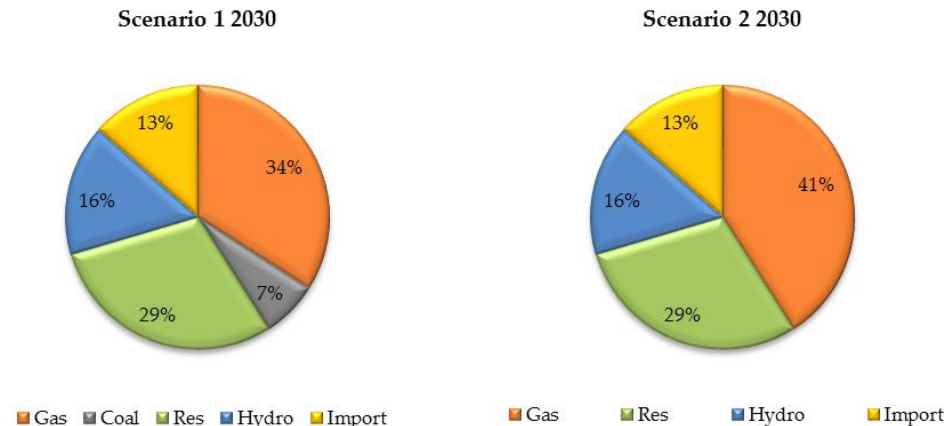
Figure 12. Electricity generation mixes for the year 2030 in both scenarios.